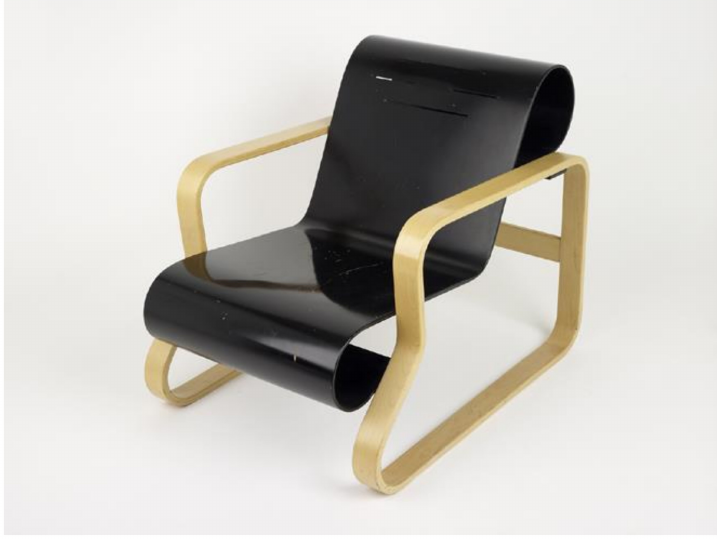
Figure 3. The Paimio Chair designed by Alvar Aalto in Finland.